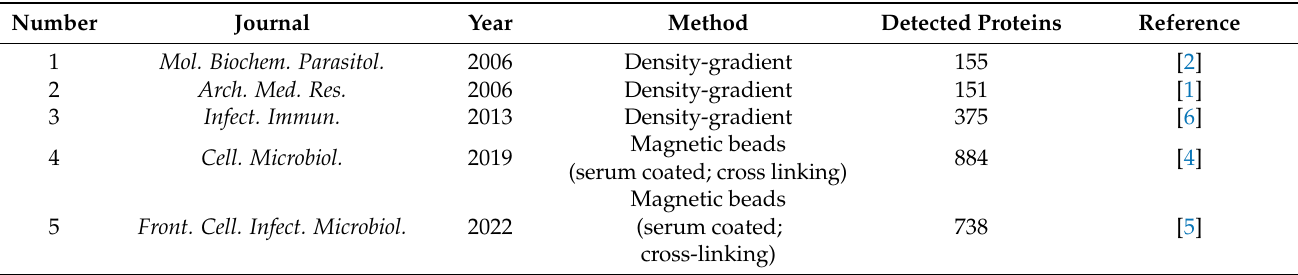
Table 1. The list of phagosome proteome performed in our laboratory. Phagosomes were purified by two different methods: the density-gradient and magnetic-bead methods. In a magnetic-bead method, beads were coated with human serum, and the samples were treated with DSP for cross-linking.